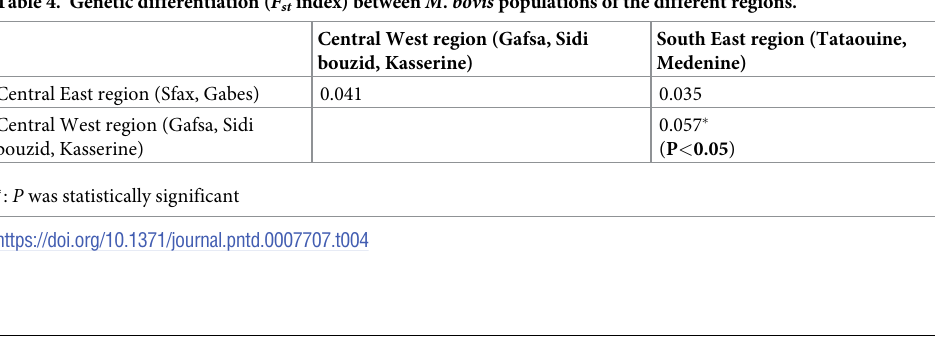
Comparison of Tunisian patients data with Tunisian cattle data